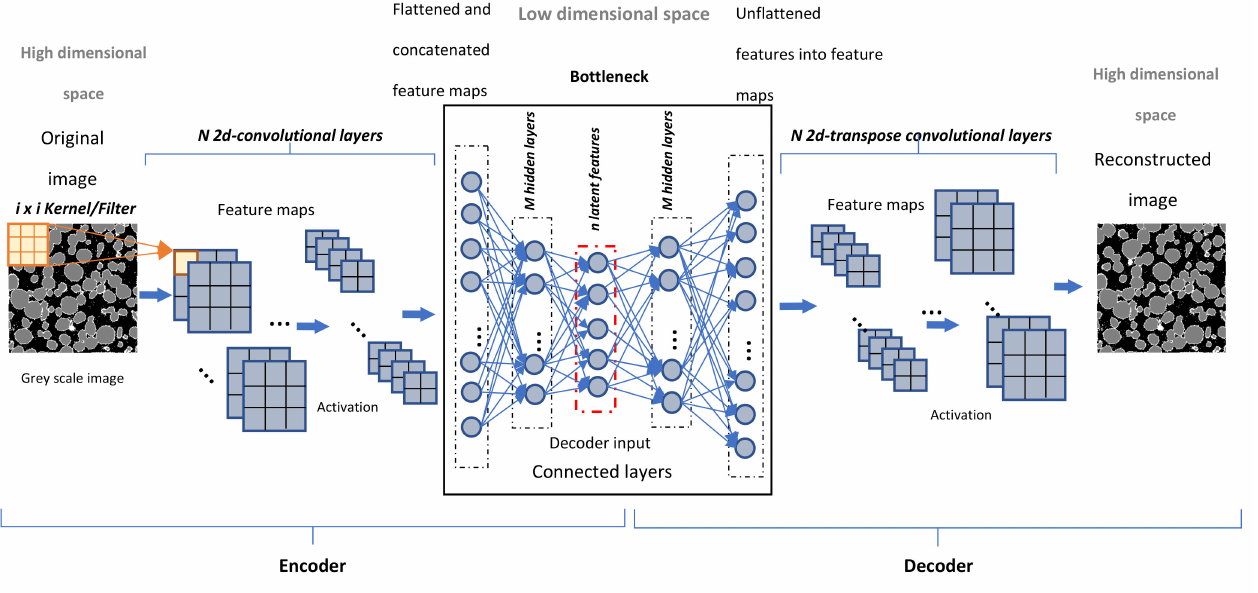
Figure 4. The schematic structure of a convolutional auto-encode-decoder.